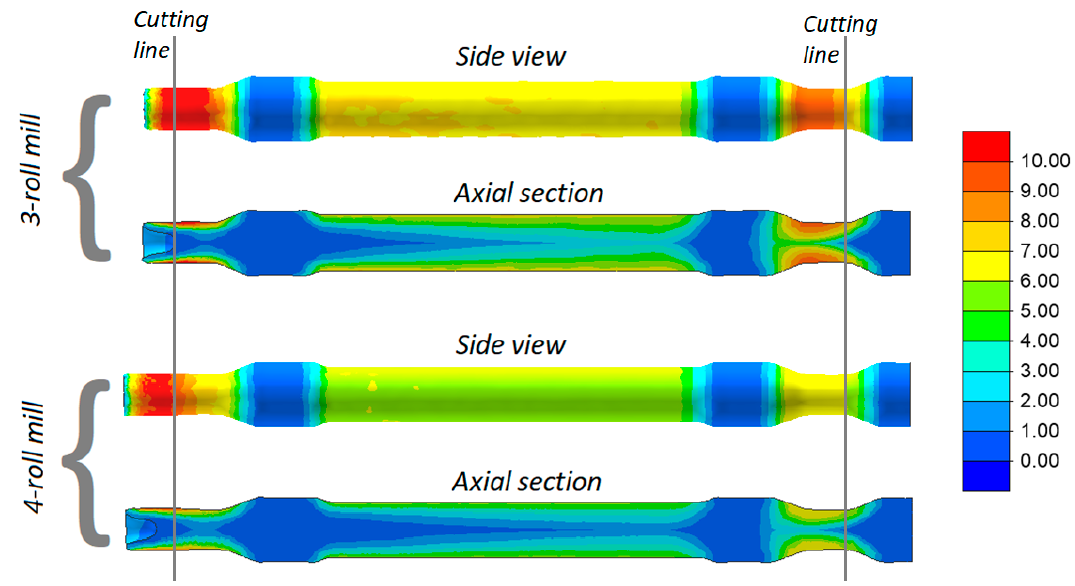
Figure 6. Effective strains in skew-rolled axles. Figure 6. E ff ective strains in skew-rolled